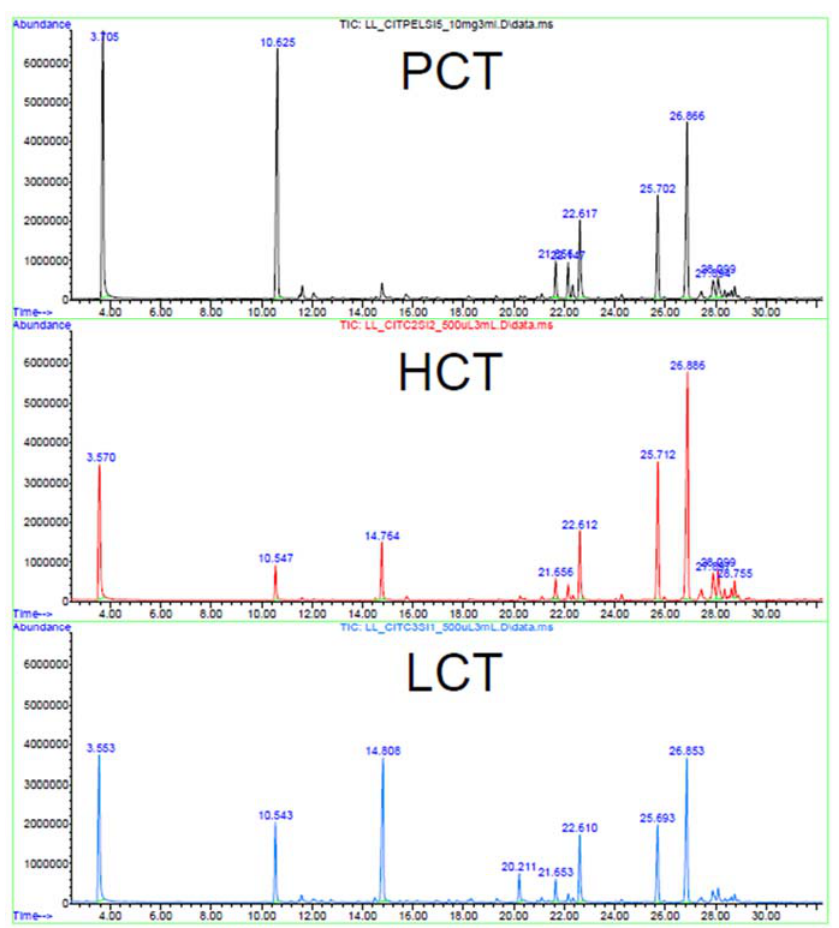
Figure 6. Superimposition of HS-SPME/GC-MS chromatograms of the HCT, LCT, and PCT samples with the respective retention time for each